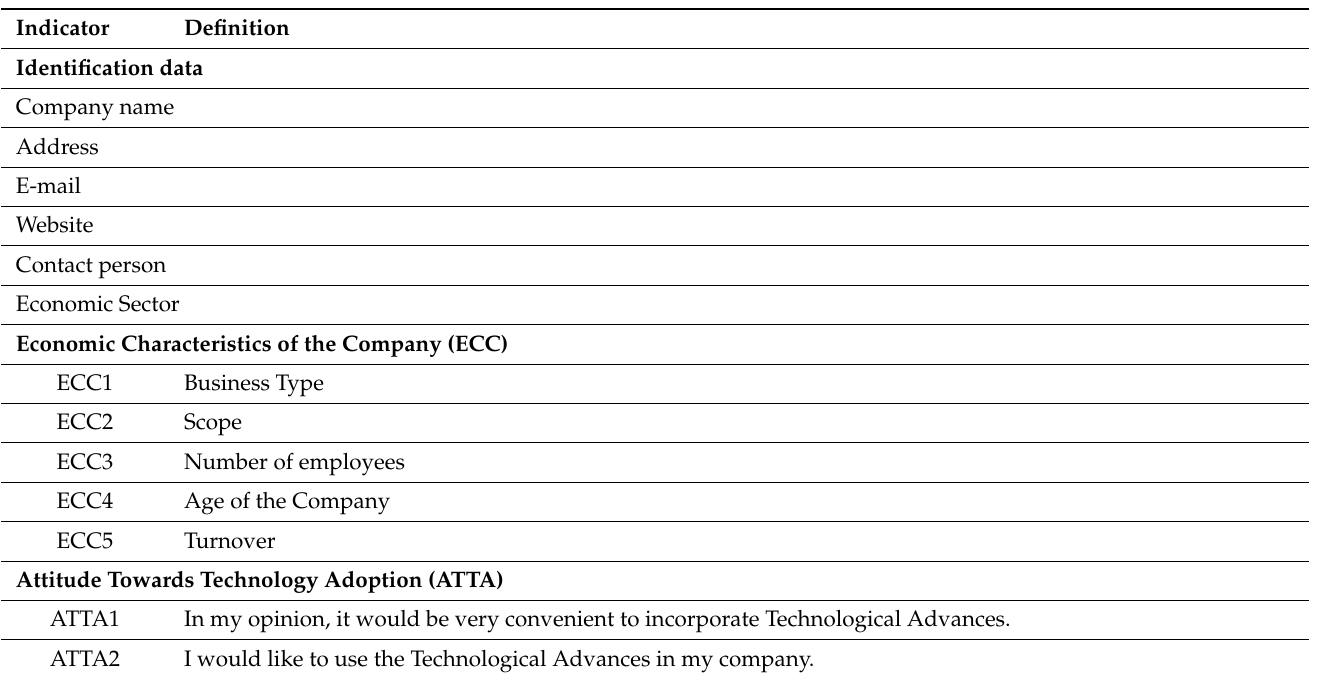
Table 1. Constructs and indicators of the measurement